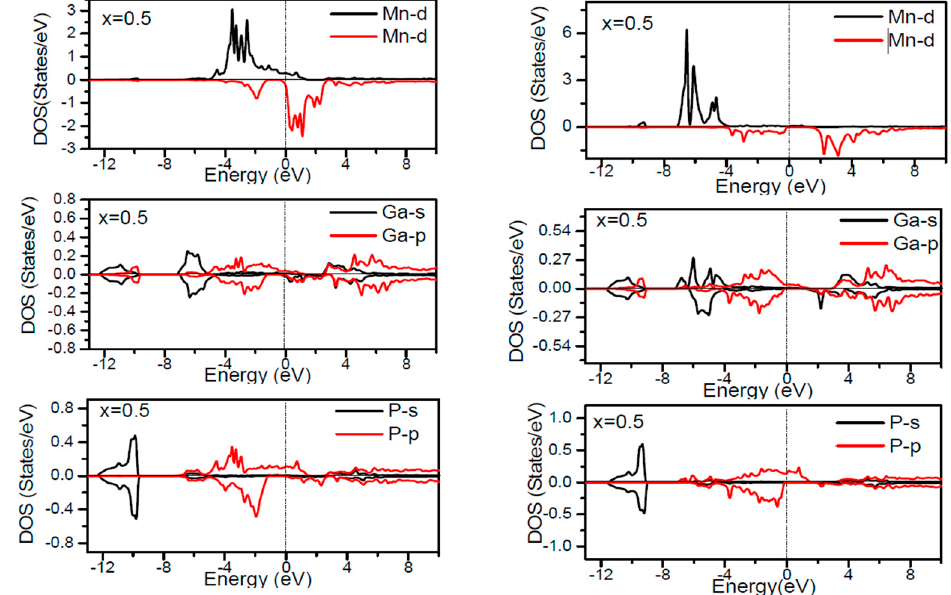
Figure 5. Computed partial DOS of spin polarized contributions from Ga-s,p, As-s,p, and Mn-d states in the Ga 1 − x MnP ( x = 0.5) alloys for spin up and spin down. The left panel indicates the GGA calculations and right panel denotes the GGA + U calculations. The vertical dash line denotes the Fermi level.